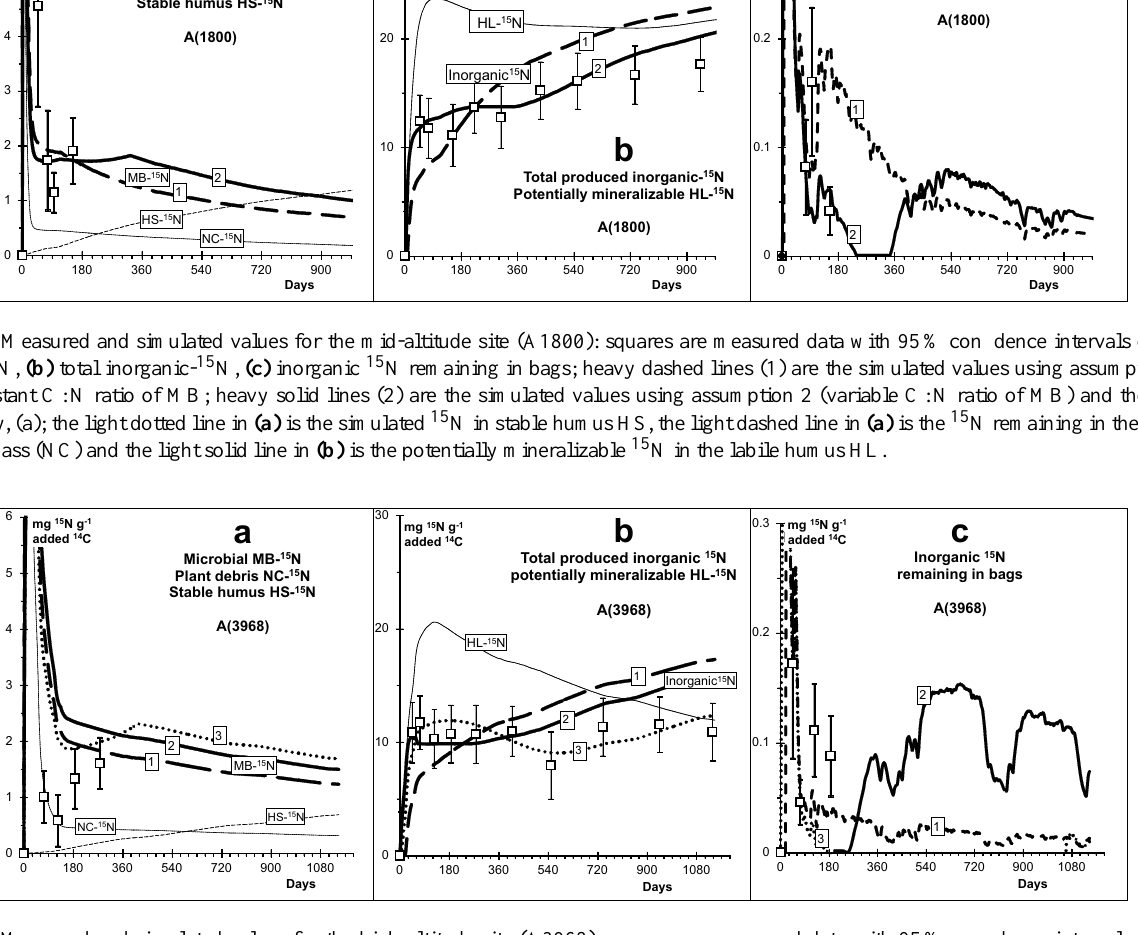
Fig. 5. Measured and simulated values for the high-altitude site (A3968): squares are measured data with 95% confidence intervals of (a) MB- 15 N, (b) total inorganic- 15 N, (c) inorganic 15 N remaining in bags; heavy dashed lines (1) are the simulated values using assumption 1 of constant C:N ratio of MB; heavy solid lines (2) are the simulated values using assumption 2 (variable C:N ratio of MB) and the first strategy (a); heavy dotted lines (3) are the simulated values using assumption 2 and strategy (b); the light dotted line in (a) is the simulated 15 N in stable humus HS, the light dashed line in (a) is the 15 N remaining in the plant necromass (NC) and the light solid line in (b) is the potentially mineralizable 15 N in the labile humus